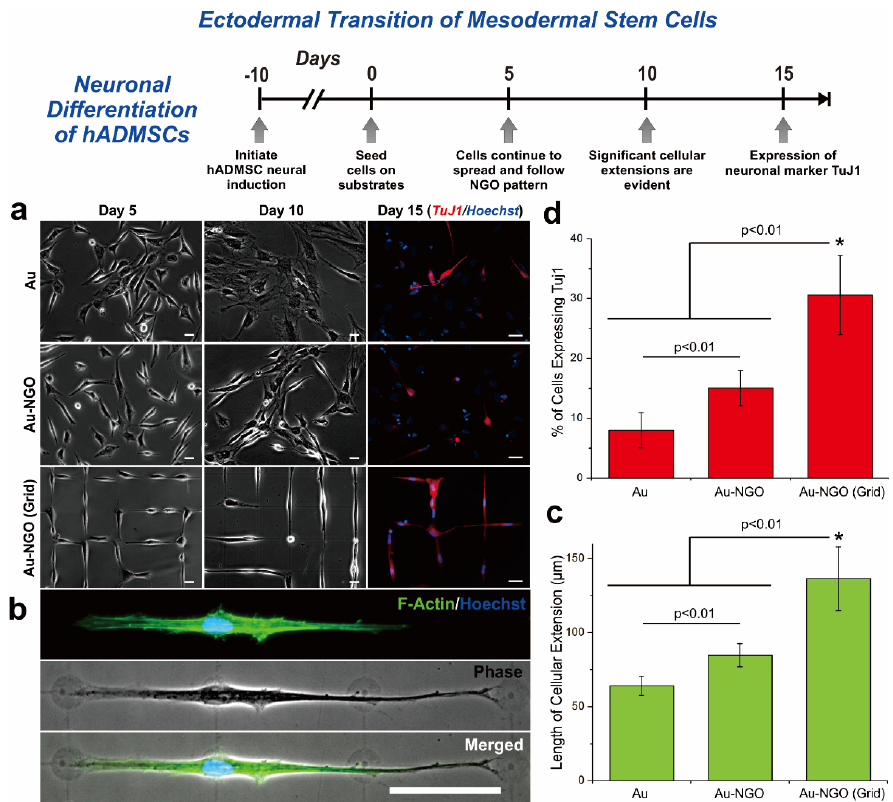
Figure 5. Enhancement of elongation and neurogenesis of human adipose ‐ derived mesenchymal stem Figure 5. Neuronal differentiation of hADMSCs using NGO grid-patterned substrate. ( a ) Pictures of cells (hADMSCs) on nano graphene oxide (NGO) grid ‐ patterned substrate. The morphological hADMSCs cultured on PLL-coated Au [Au], NGO-coated Au [Au-NGO], and NGO grid-patterned characteristics of hADMSCs and their differentiation were confirmed by staining for the F ‐ Actin substrates [Au-NGO (Grid)]. Differentiation of hADMSCs confirmed by the neuronal marker TuJ1 (green), neuronal marker TuJ1 (red), and nucleus (blue). Scale bars = 20 μ m. Reprinted with (red) and nucleus (blue). Scale bars = 20 µ m; ( b ) Optical and fluorescence images of hADMSCs stained permission from [70]. Copyright 2015 American Chemical Society. for F-actin (green) and nucleus (blue). Scale bar = 50 µ m; ( c ) Quantitative analysis of the length of cellular extension on various substrates ( n = 3; * p < 0.01, Student’s unpaired t test); ( d ) Quantitative analysis of the percentage of cell showing the neuronal marker TuJ1 on various substrates ( n = 3; * p < 0.01, Student’s unpaired t test). Reprinted with permission from [82]. Copyright 2015 American Chemical